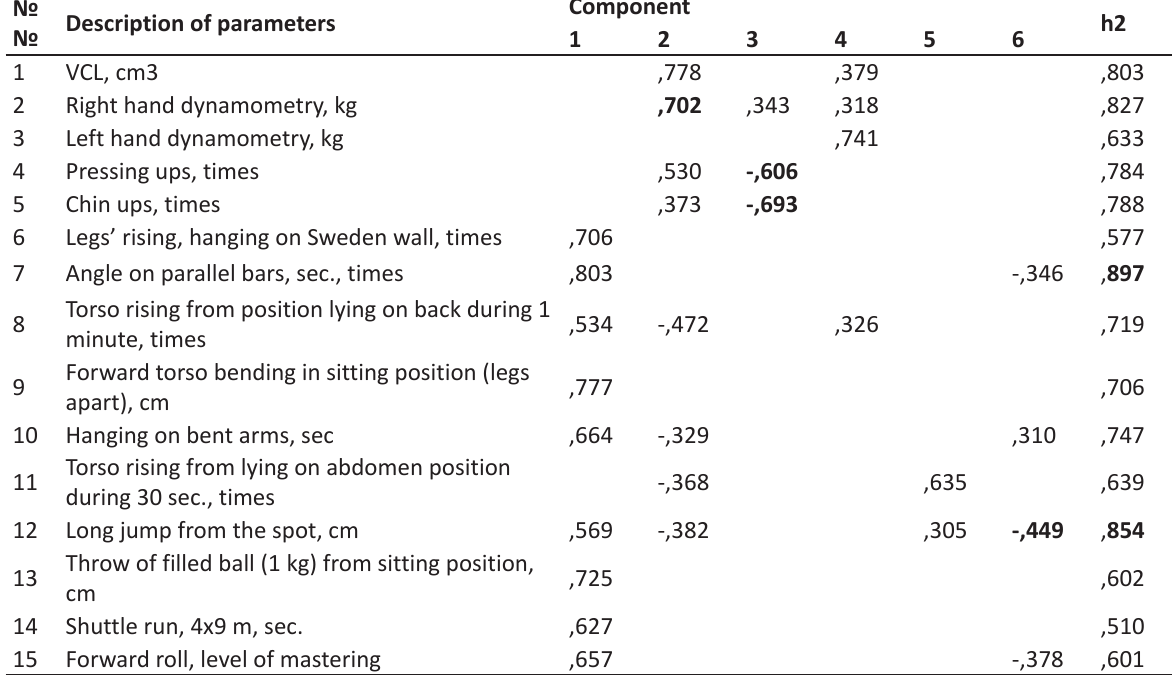
Table 2. Matrix of factorial analysis of 11 yrs boys’ testing. Rotation method: Varimax with Keiser’s normalization № Description of №